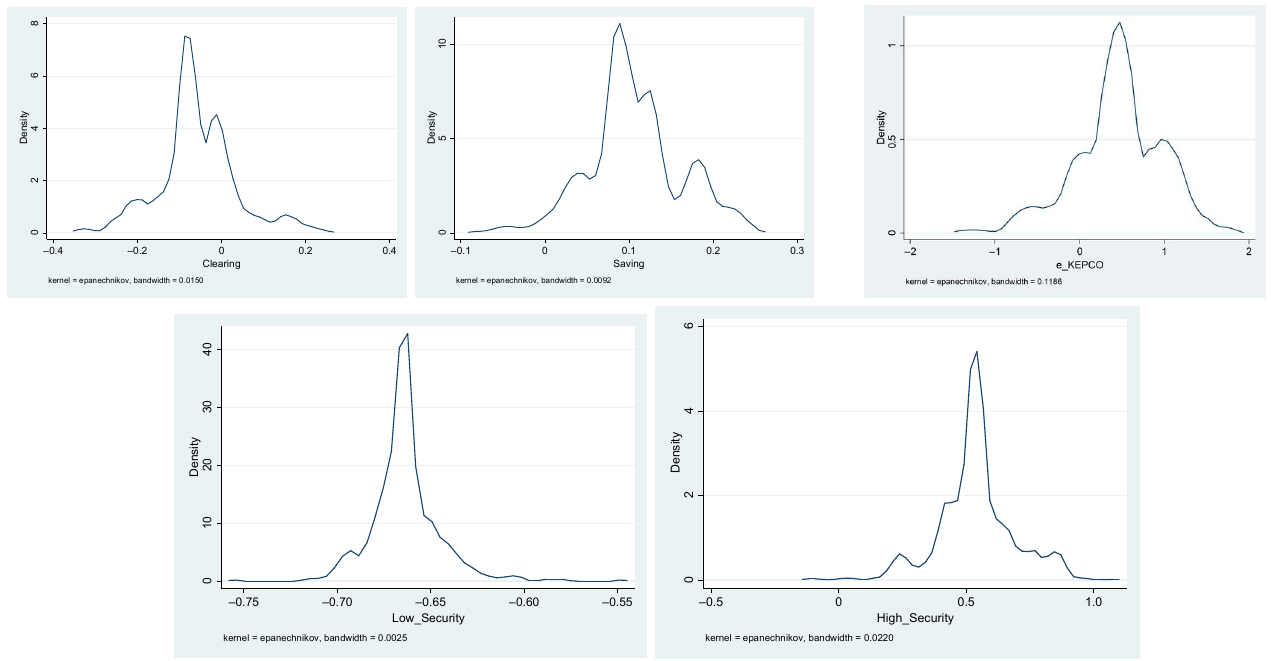
Figure 4. Kernel Density Plots for Attributes of Mixed Logit Model. As mentioned above, respondents in class II and class III are indifferent to the P2P ETP, while respondents in class I prefer the opt-out option. Thus, we may eliminate these three classes and examine Kernel density plots for class IV respondents. Figure 5 illustrates that class IV respondents have higher preferences for low clearing times ( Clearing ) and KEPCO ( e-KEPCO ) as a trading agent. They are also more sensitive to security levels relative to total sample of the mixed logit estimation (MLM). The density distributions for all attributes have single peaks. Similar to the Kernel density analysis for the MLM estimation, respondents indicate positive and negative preferences for Clearing , Saving, and e-KEPCO but only negative preference for Low_Security and only positive preference for High_Security attributes.